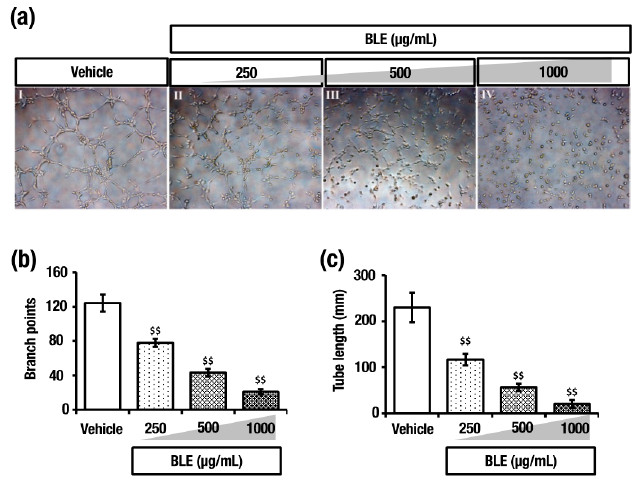
Figure 8. Boiled leaf extract (BLE) of O. octandra inhibited angiogenesis in the HUVEC model. ( a ) Representative micrographs of 4 h post-seeding. (I) HUVECS were attached, aligned and organized in tubes with a lumen that appeared as a network when cultured on ECM. (II–IV) In the presence of O. octandra extract, HUVECs were attached but remained somewhat rounded as solitary cells. The effect of O. octandra was dose-dependent, and when the concentration increased from 250 to 1000 µg/mL, branching and tube formation was significantly inhibited . ( b ) Cumulative tube length and ( c ) number of branch points of capillary-like structures were also significantly reduced at 4 h. Error bars represent the standard error of the means (SEM) in each group ( n = 3). The statistical significance was calculated with one-way ANOVA followed by Dunnett’s test. $, significant decrease; $$, p = 0.001 to 0.01.